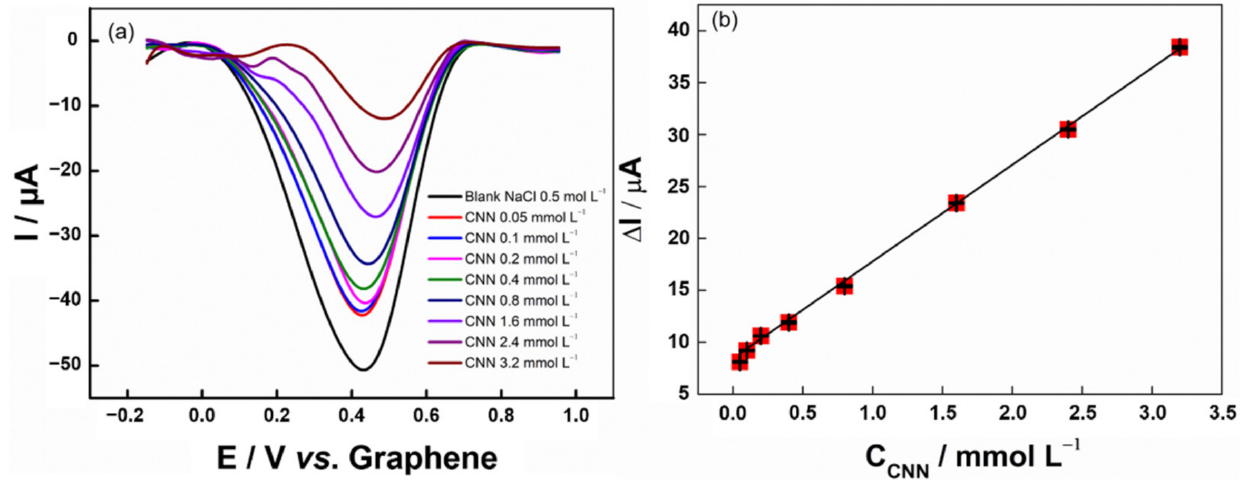
3.2 mmol L − 1 ) in 0.5 mol L − 1 NaCl. SWV parameters: − 5.0 mV (step potential); 20 mV (modulation amplitude); 10 Hz (frequency), ( b ) The analytical curve was obtained from the variation of I peak as a function of CNN